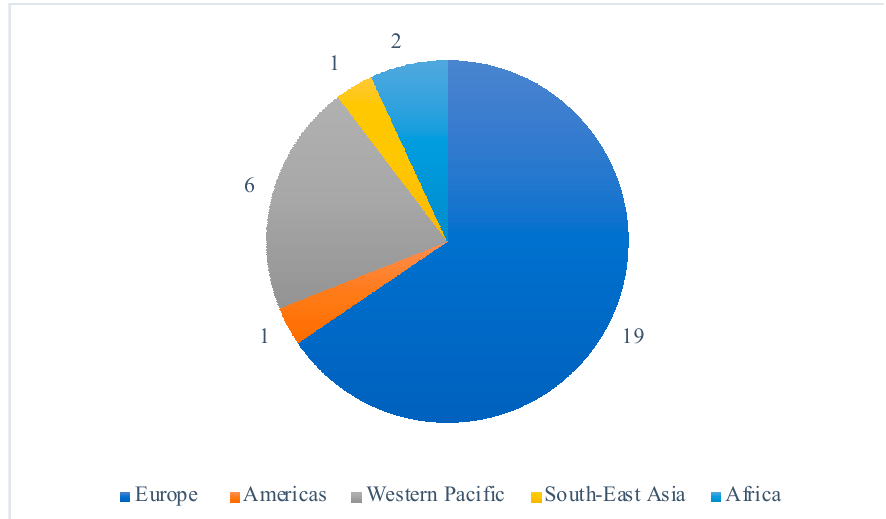
Figure 2. Distribution of the included study’s location sites by WHO region.